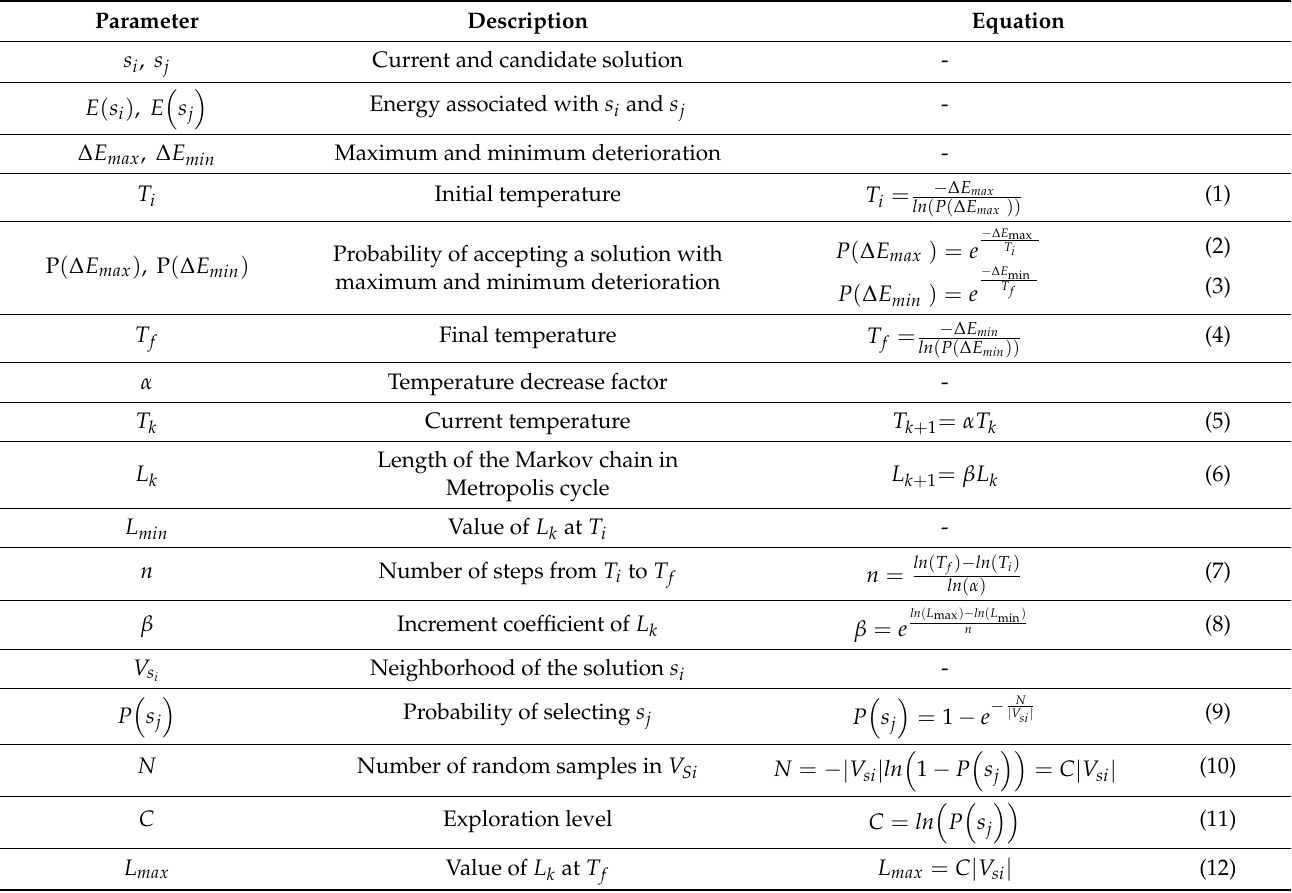
Table 1. Parameters used for SA and TA Analytical